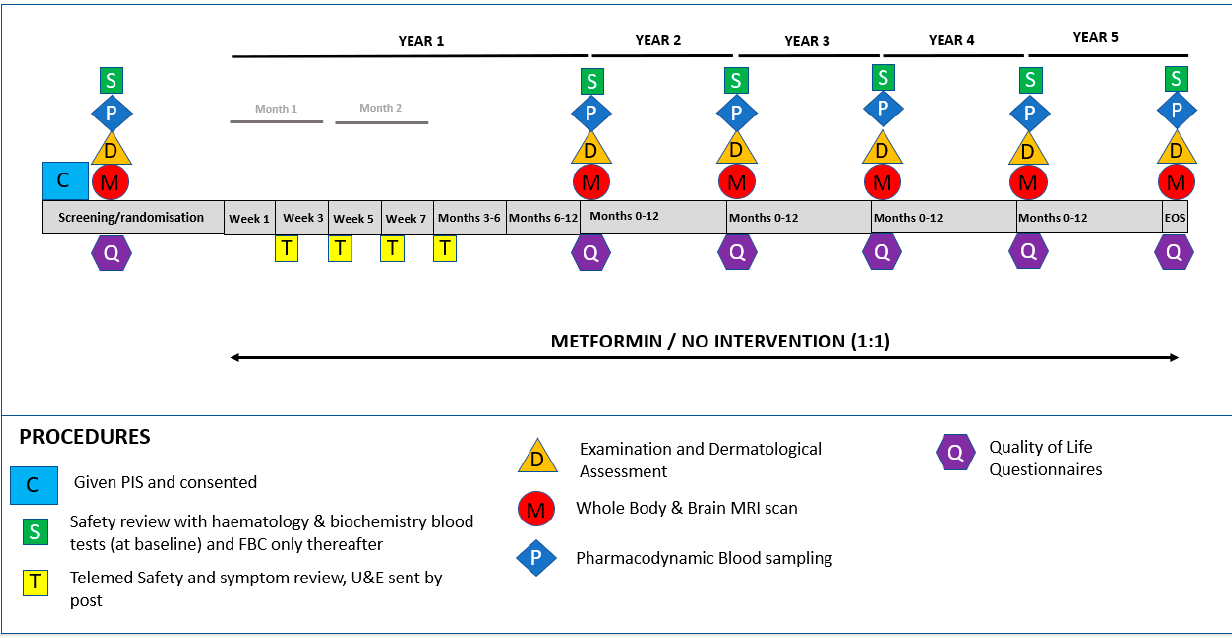
Figure 3. MILI trial schema.